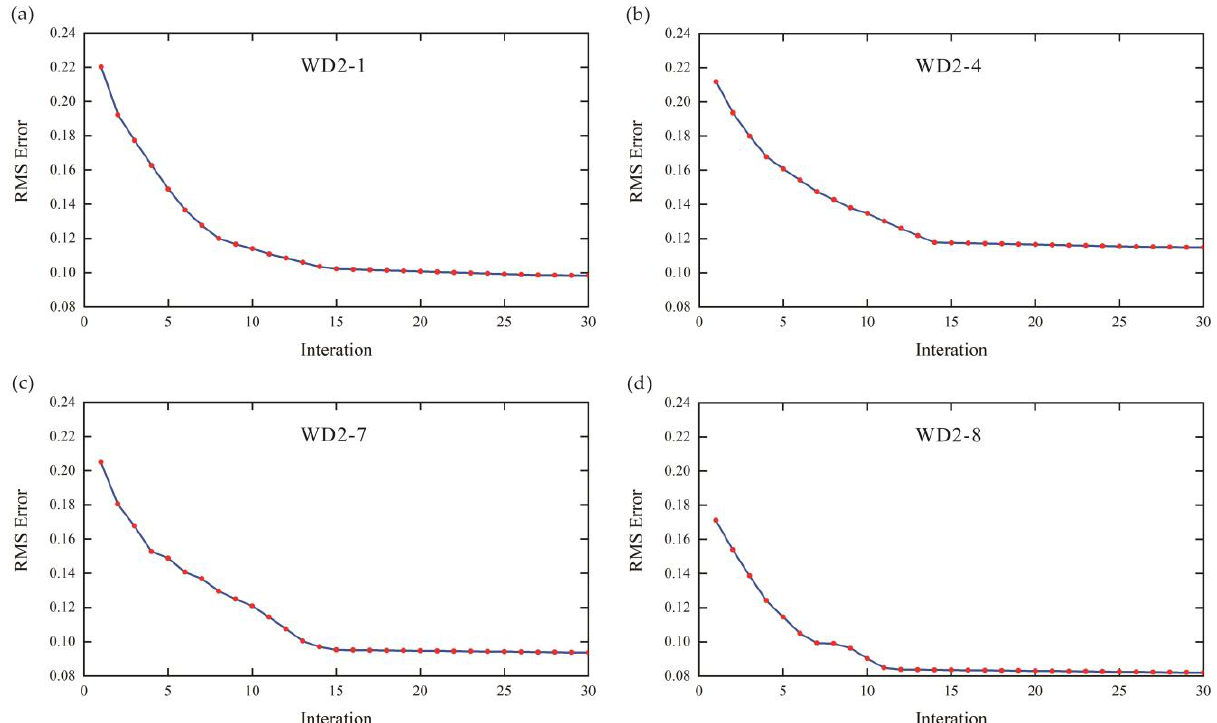
Figure 10. The change in fitting mean square deviation of dispersion curve of some measuring points of WD2 line with the number of iterations: ( a ) the RMS error of WD2-1; ( b ) the RMS error of WD2-4; ( c ) the RMS error of WD2-7; and ( d ) the RMS error of WD2-8.